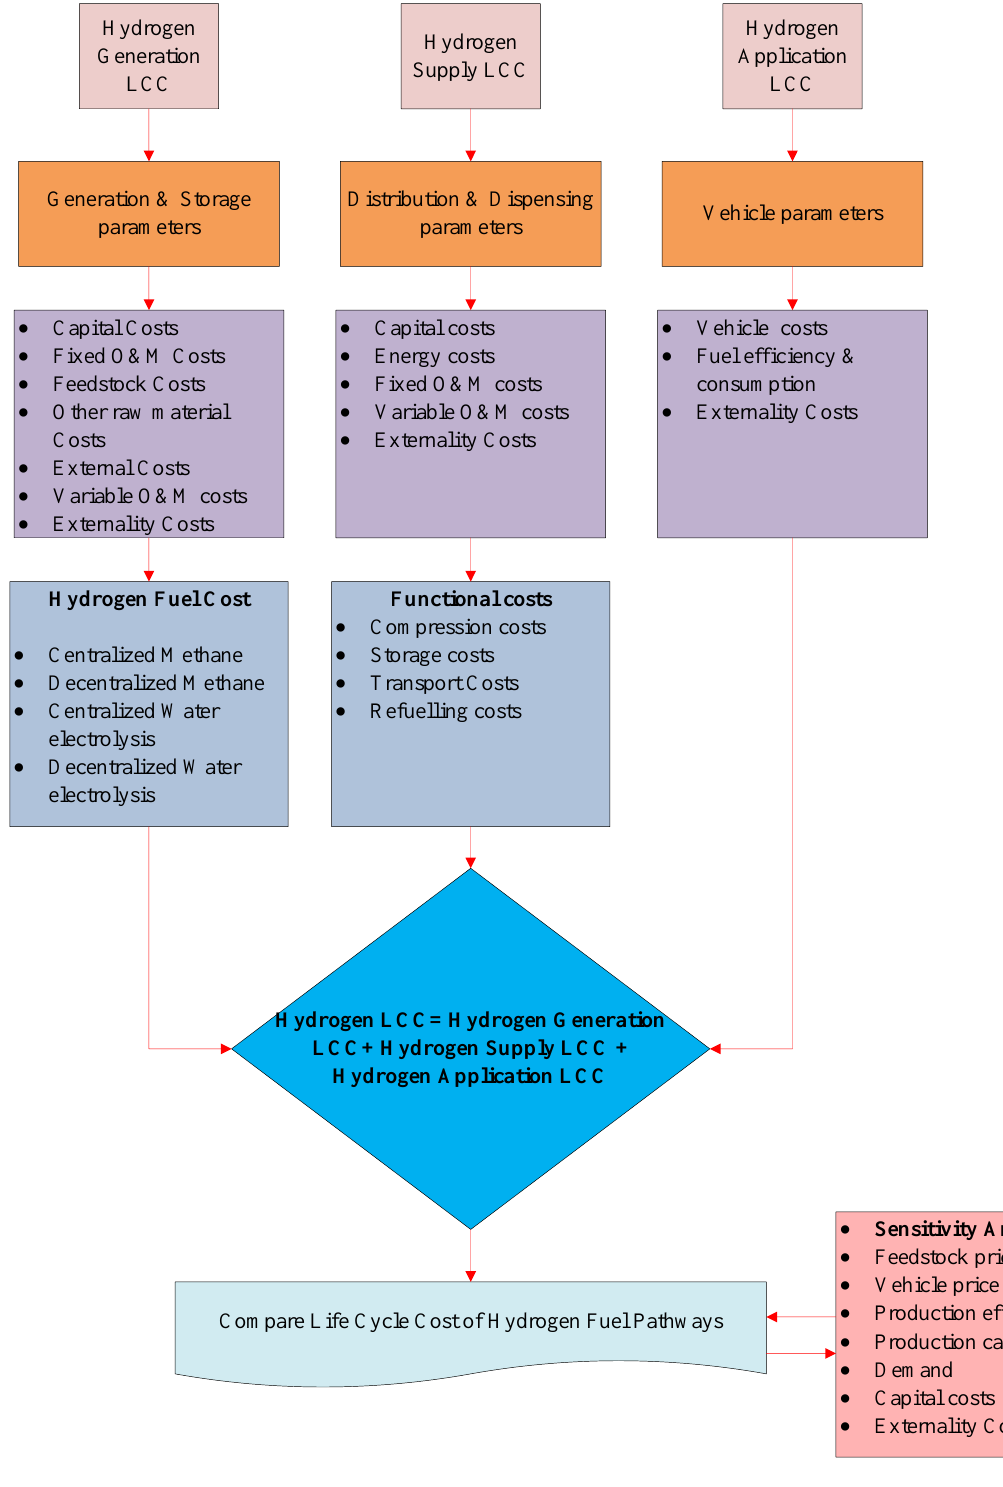
Figure 2. Proposed life cycle costing model structure and strategy for hydrogen fuel costing analysis.